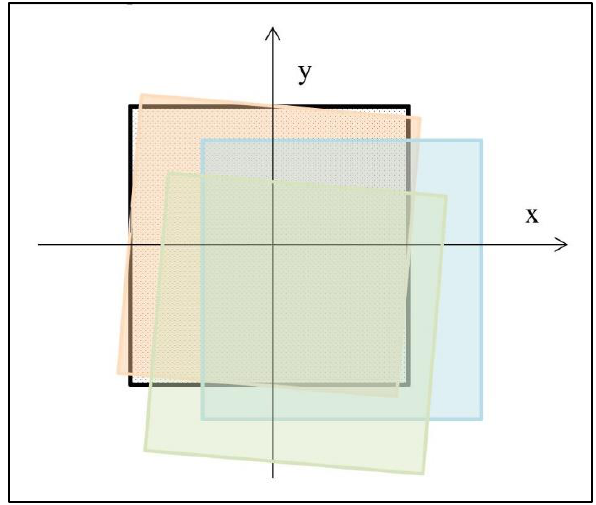
Figure 3 . Graphical example of angular (orange), parallel (blue) and combined misalignment (green) with respect to the original position of the black board square along the X and Y